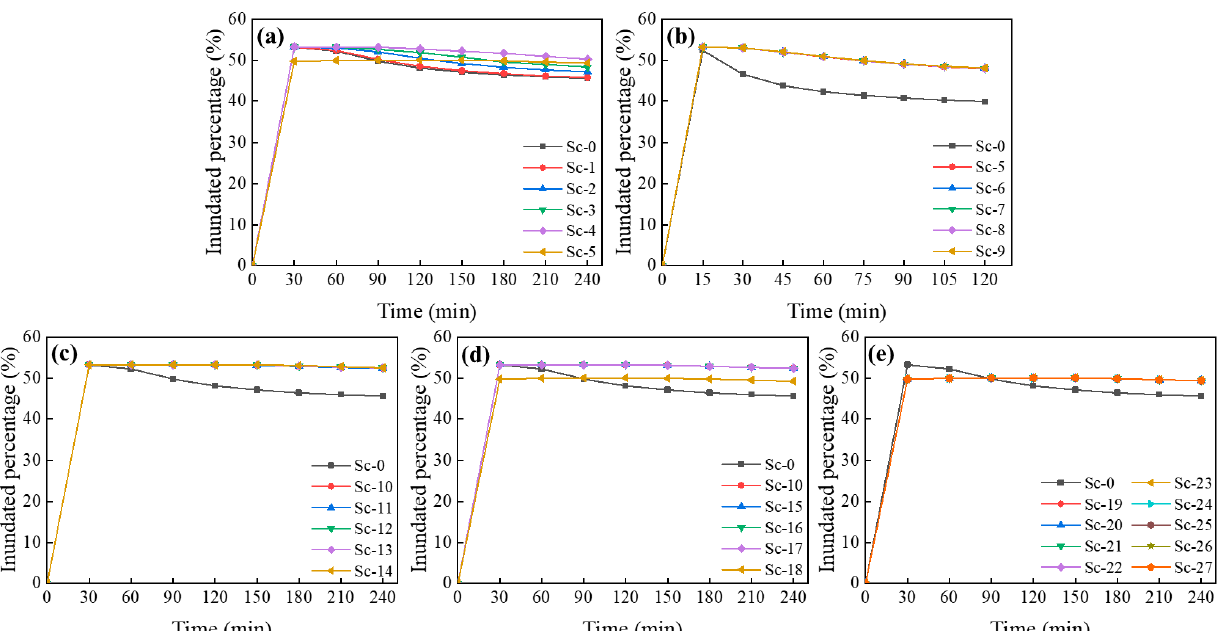
Figure 18. The time series plot of IA in 3 h event in considered scenarios of ( a ) connectedness of GR; ( b ) connectedness of RG; ( c ) edge density of GR; ( d ) edge density of RG; ( e ) flow distance of RG.